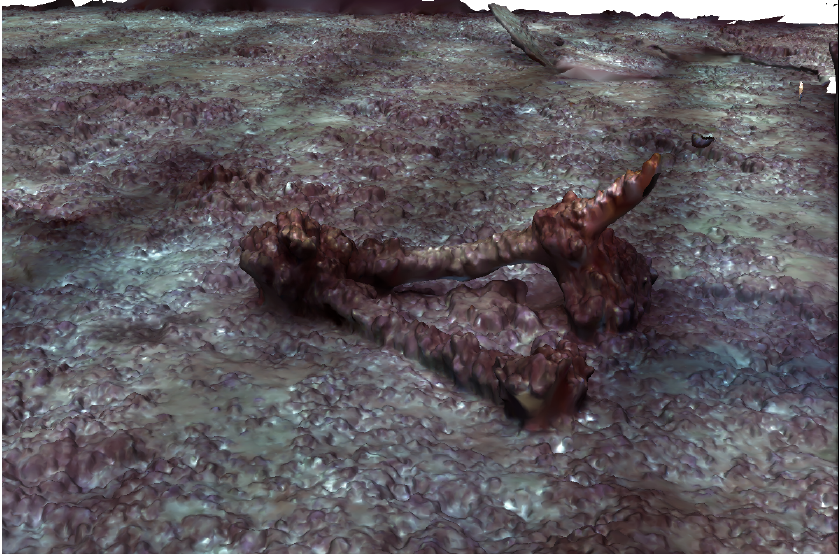
Figure 32. Different viewpoint of the 3D reconstruction of the shipwreck shown in Figure